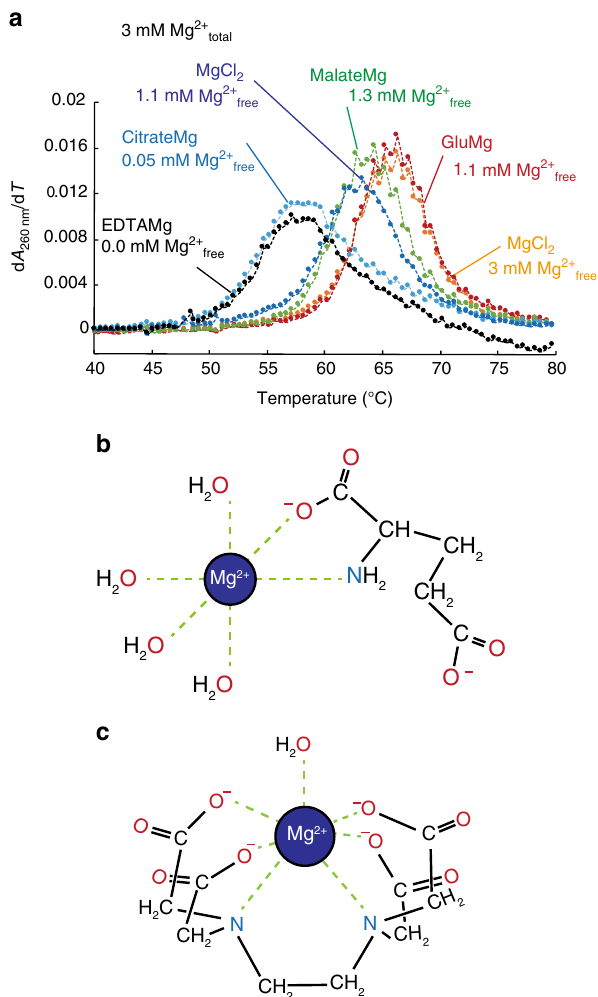
Fig. 5 Coordinated water molecules are critical for RNA stabilization. a Melting curves of drz-spur-3 ribozyme in the background of metabolites. 3 mM Mg 2 + total (orange) and 28 mM of glutamate (red), malate (green), citrate (cyan), or EDTA (black) conditions were tested. As a control, 1.1 mM Mg 2 + total (blue) condition was performed. The estimated concentrations of Mg 2 + free are provided. K D ’ s are given in the main text. b Chemical structure of glutamate and magnesium. Glutamate interacts with magnesium through N, O-chelation. c Chemical structure of EDTA and magnesium.